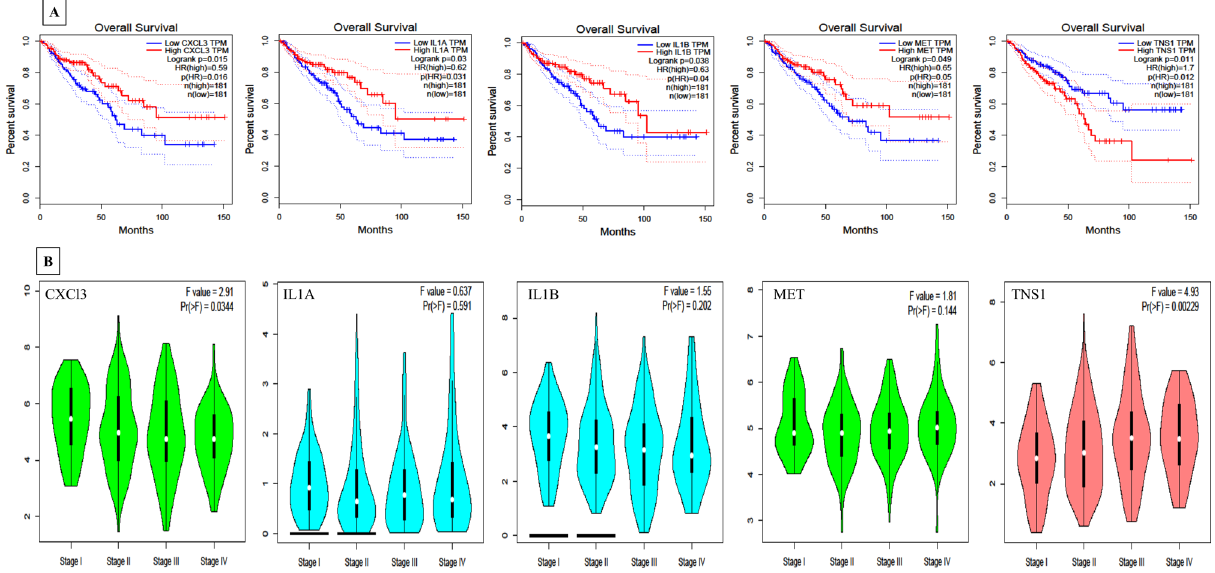
Figure 5. TCGA based validation and survival analysis on GEPIA (http:// gepia. cancer- pku. cn/ index. html). ( A ) Overall survival analysis of significant hub genes on TCGA using the COAD cohort. ( B ) Gene expression analysis of TNS1, CXCL3, MET, IL1B and IL1A in all stages (I–IV) of CRC.